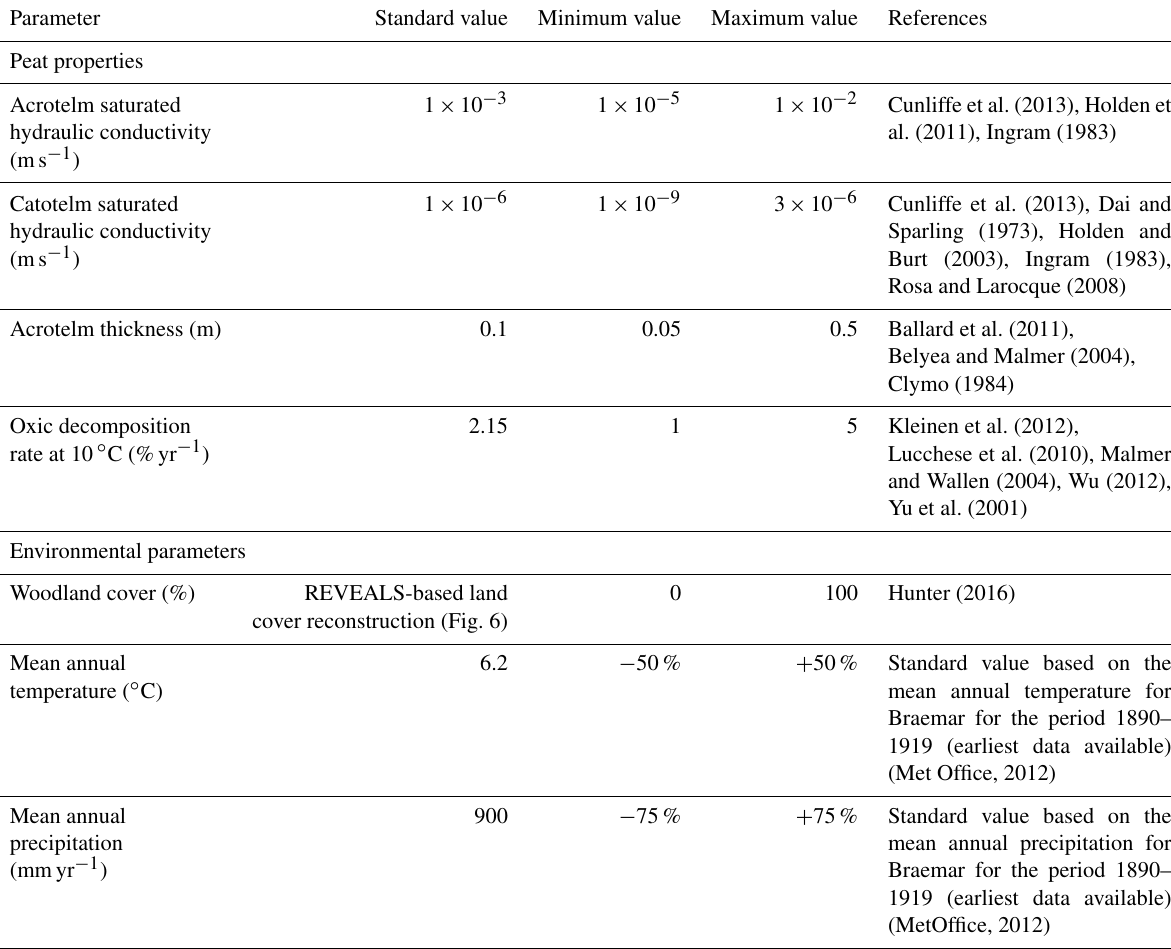
Table 1. Overview of the parameters used in the parameter sensitivity test, listing the standard value and the range over which the parameter is